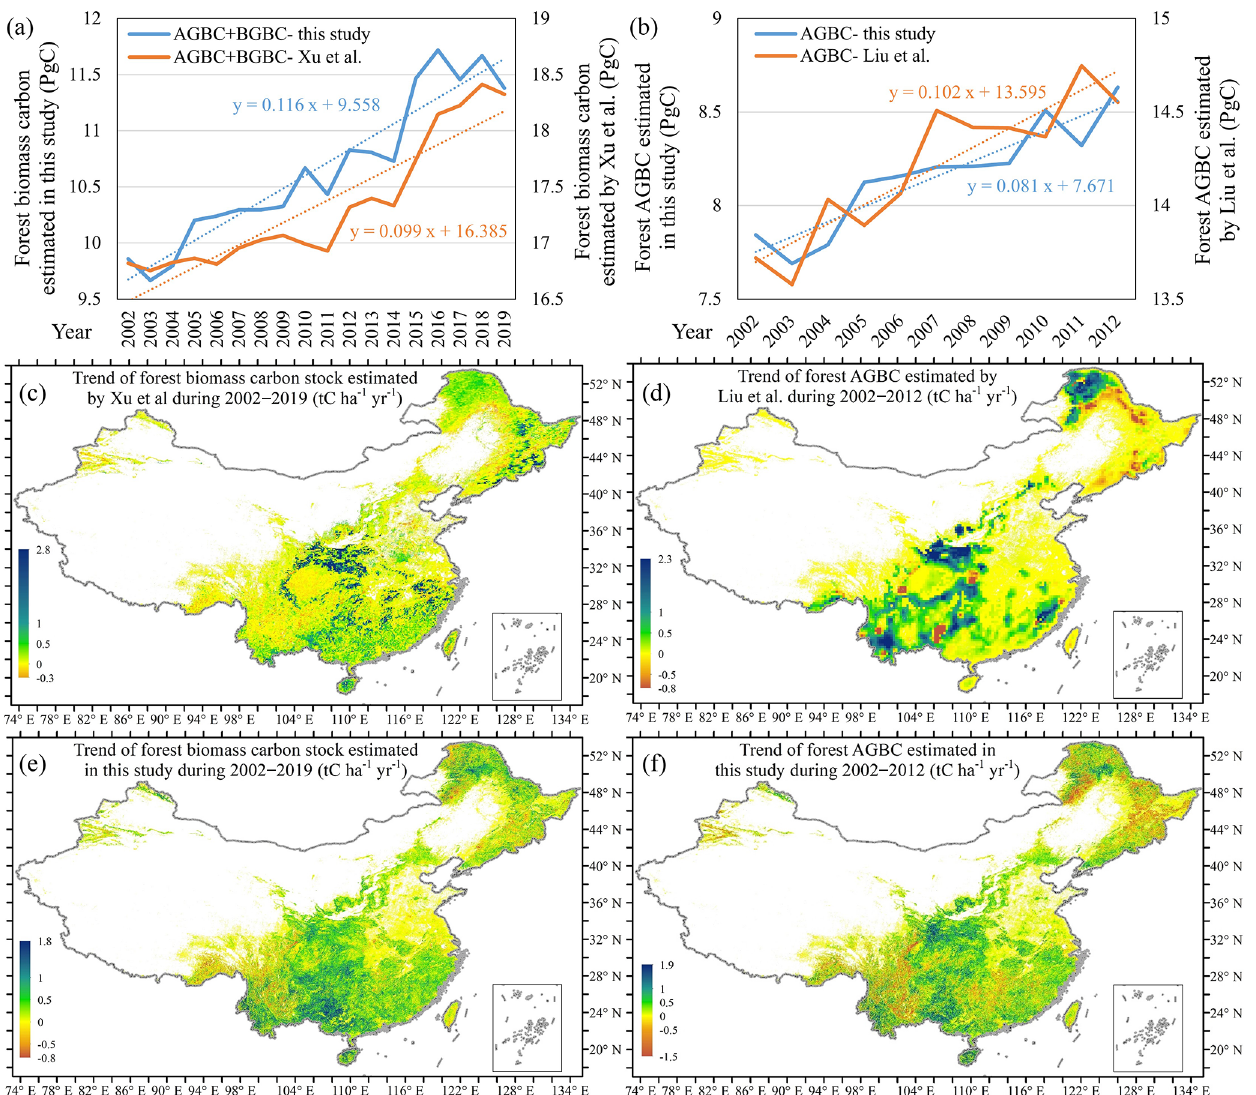
Figure 7. Comparison of the estimated forest biomass carbon pool change in this study with two existing datasets. (a) Comparison of the interannual variation in forest biomass carbon in this study with the estimate by Xu et al. (2021) during 2002–2019. (b) Comparison of the interannual variation in forest AGBC calculated in this study with the estimate by Liu et al. (2015) over 2002–2012. (c) Map of the interannual trend of forest biomass carbon stock in China during 2003–2019, according to Xu et al. (2021). (d) Map of the forest AGBC trend in China during 2003–2012, according to Liu et al. (2015). (e) Map of the estimated trend of forest biomass carbon stock over 2002–2019 in this study. (f) Map of the estimated forest AGBC trend over 2002–2012 in this